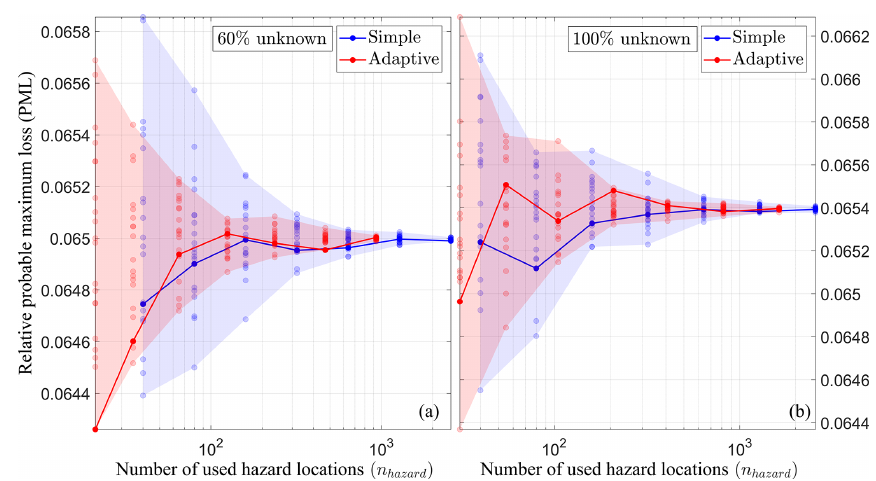
Figure 13. Convergence plots showing relative probable maximum loss (PML) at a return period of 100 years against the number of used hazard locations n hazard for portfolios of n r = 10 risk items with 60% (a) and 100% (b) unknown coordinates using simple MC (shown in blue) as well as the adaptive scheme (shown in red). Semitransparent circles depict R = 20 repeated simulations for each sample size, and solid lines highlight one repetition. The transparently shaded background shows the entire range for each sampling scheme. The plots show that the adaptive scheme scatters less and converges faster to the same result than simple sampling.